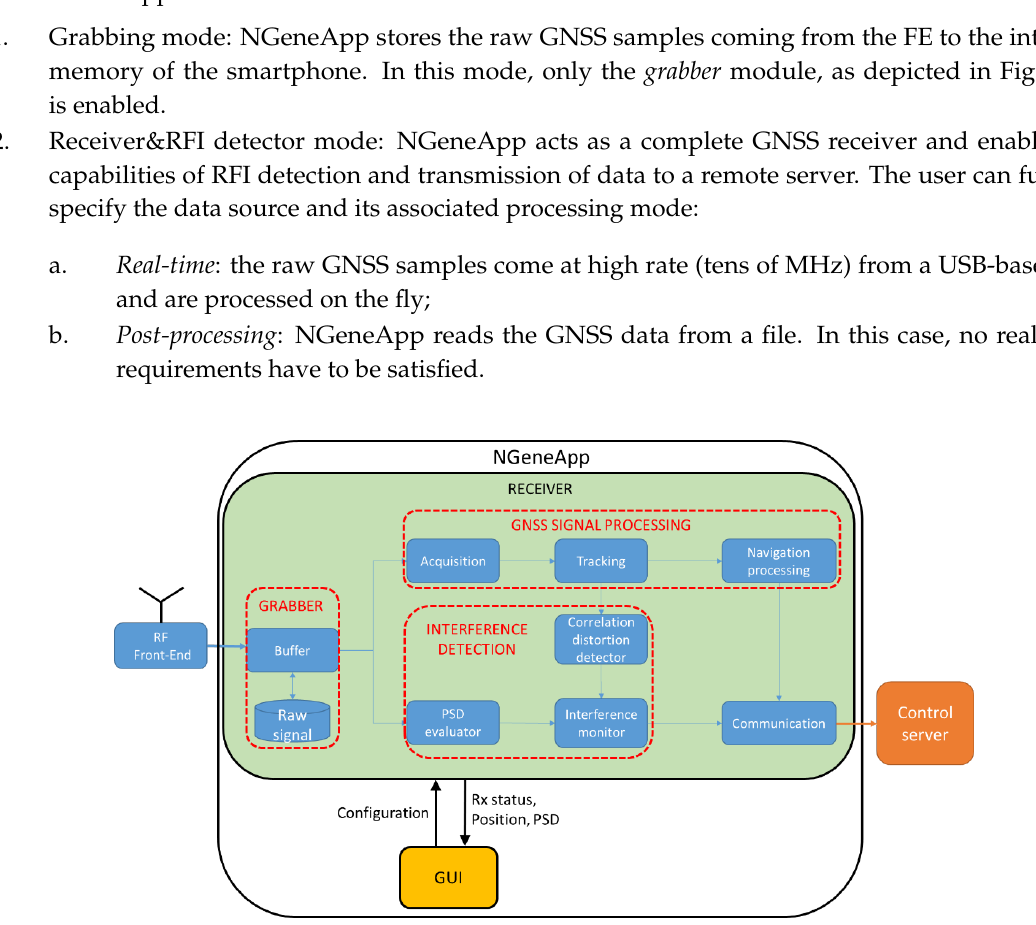
Table 1. FEs supported by NGeneApp.